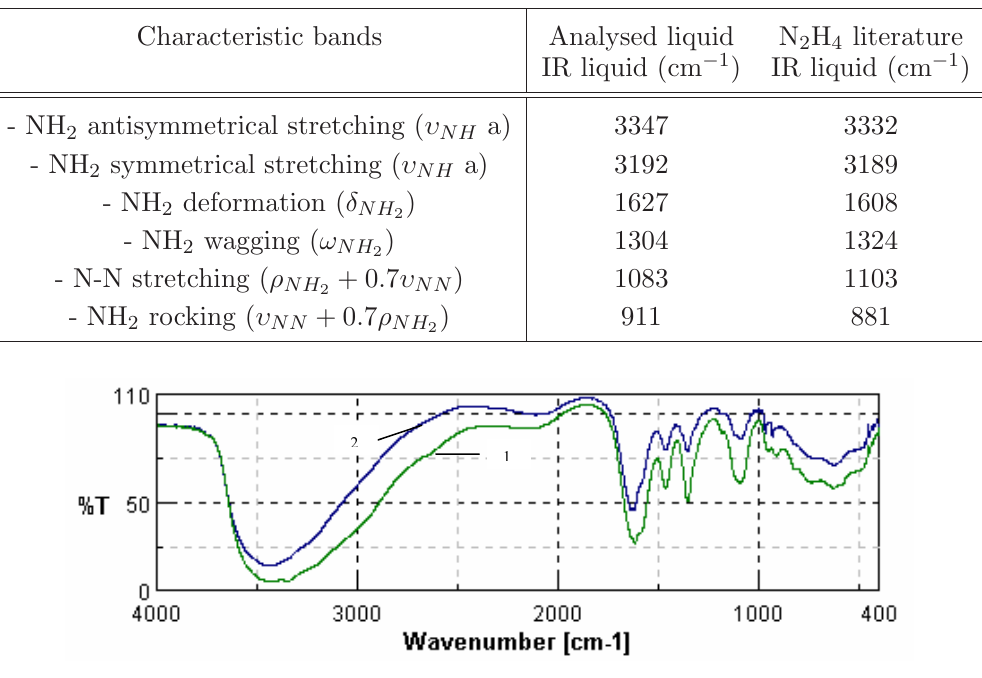
Fig. 2 Superposition of the kinetic curves obtained by numerical integration: symbol ( (cid:7) , (cid:4) , N ): reduced model; full line: experimental curves. Table 2 Fundamental frequencies of N 2 H 4 and of the liquid under analysis.